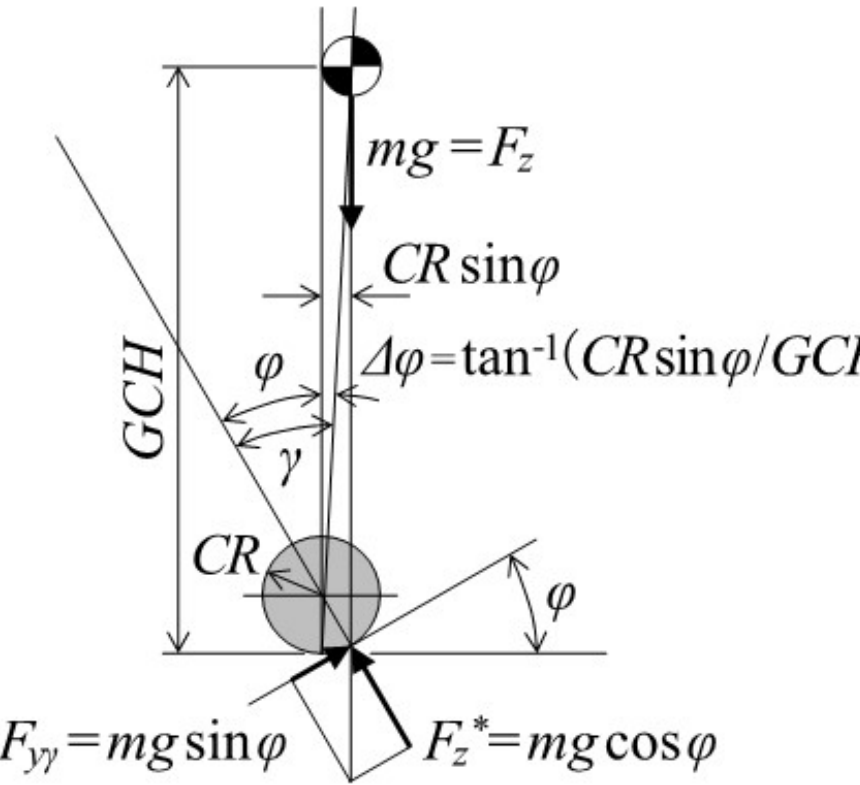
Figure 16. Lateral movement of the grounding point on a slanted road. Equation (21) must hold in order to balance the lateral forces at zero slip angle ( β